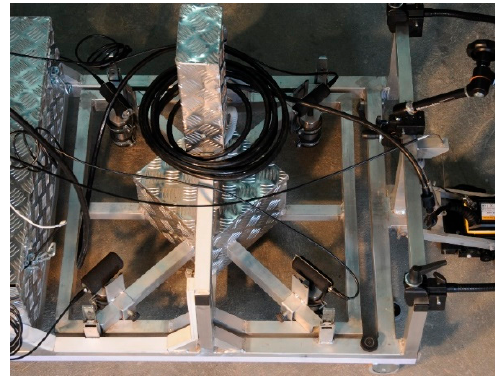
Figure 19. Impact-Echo module integrated into scanner.